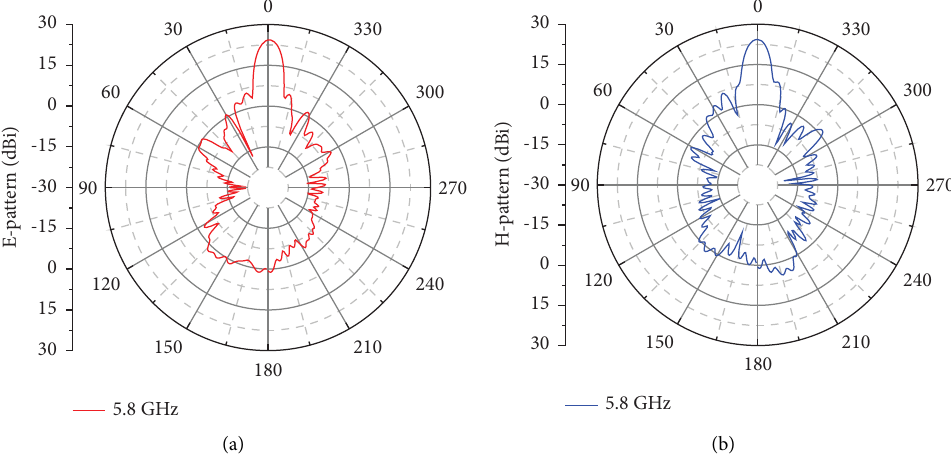
Figure 15: E -feld and H -feld radiation patterns.